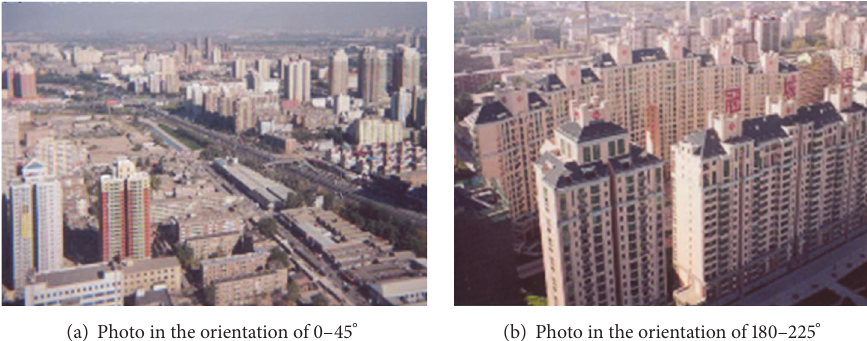
Figure 2: Photos of the Beijing meteorological tower in various orientations, where (a) represents the northeast direction and (b) represents the southwest direction.